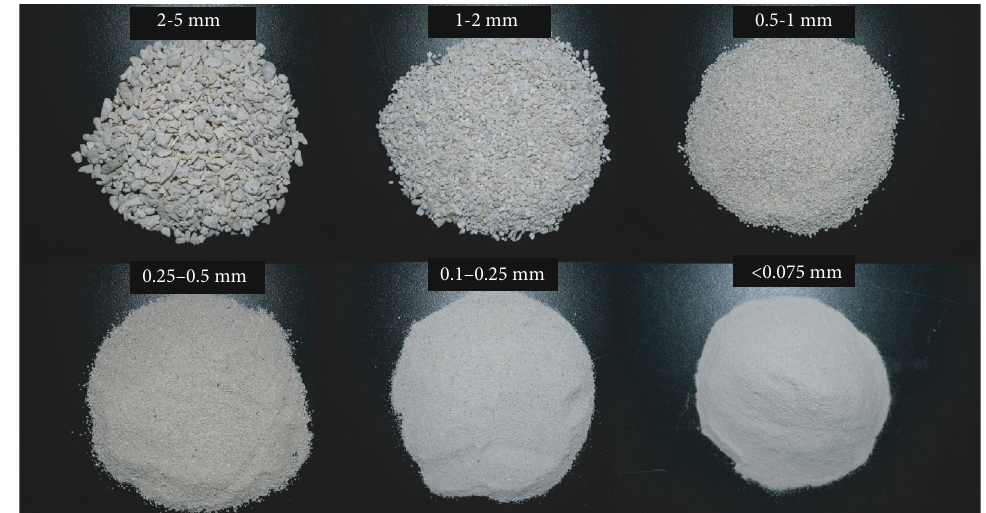
Figure 3: Sand samples of di ff erent grain sizes.